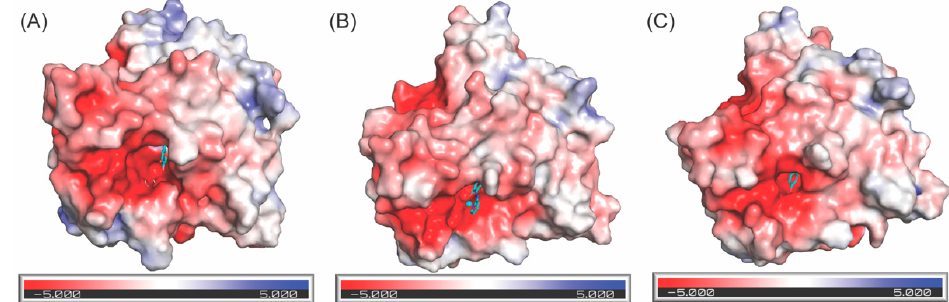
Figure 13. Electrostatic potential on the surface of the 3D − modeled catalytic domain of the resting form of LOXL2 ( A ), 2HP − inhibited LOXL2 ( B ) and the crystal structure of the Zn 2+ − bound precursor LOXL2 ( C ). LTQ, LTQ − 2HP and Tyr689 (all in cyan) are exposed to the solvent. The acidic groove surrounding the LTQ cofactor and Cu 2+ most likely accommodates substrate (Lys − containing pep- tides) binding.